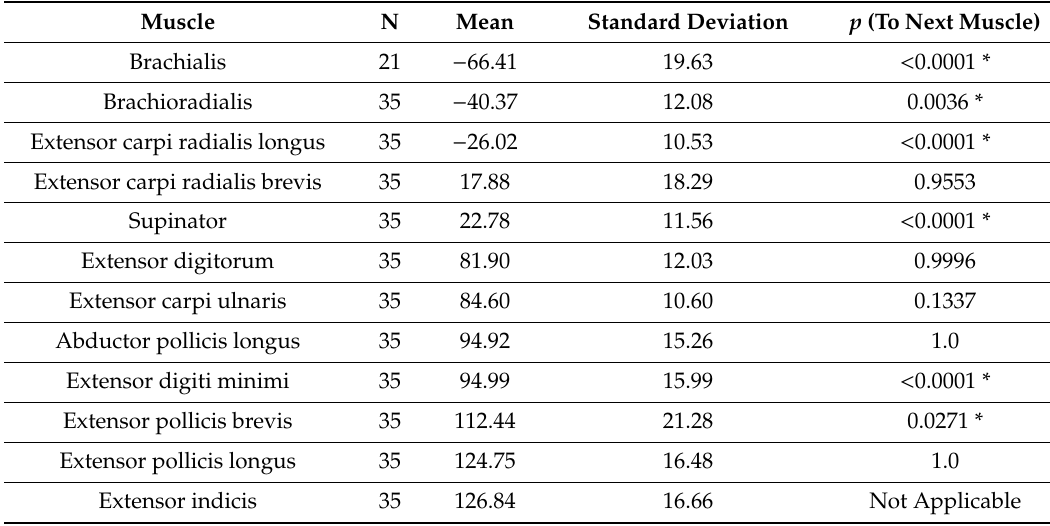
Table 1. Branching order, based on the mean distance in mm along the trunk from the transepicondylar line to the first branch to a muscle. p values are listed for the comparison of a mean to the one below it. p values comparing any muscle to another muscle not adjacent to it on this table were all < 0.05, except for the extensor carpi ulnaris (ECU) and extensor digiti minimi (EDM) ( p =